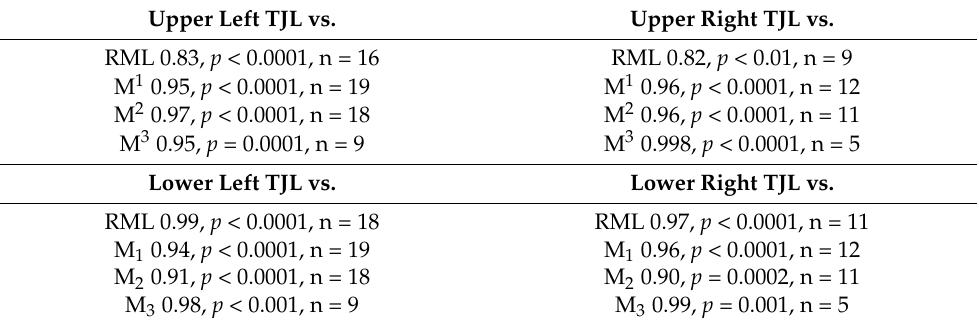
Table 6. Pearson’s Correlation Coefficient (r) of total jaw length (TJL) with retromolar length (RML), and molar lengths (M1, M2, M3), showing strong and significant correlations in all four quadrants among upper and lower jaws. Strength of correlation between TJL and RML was highest in the mandible (0.97–0.99) versus the maxilla (0.82–0.83). Upper Left TJL vs. Upper Right TJL vs. RML 0.83, p < 0.0001, n = 16